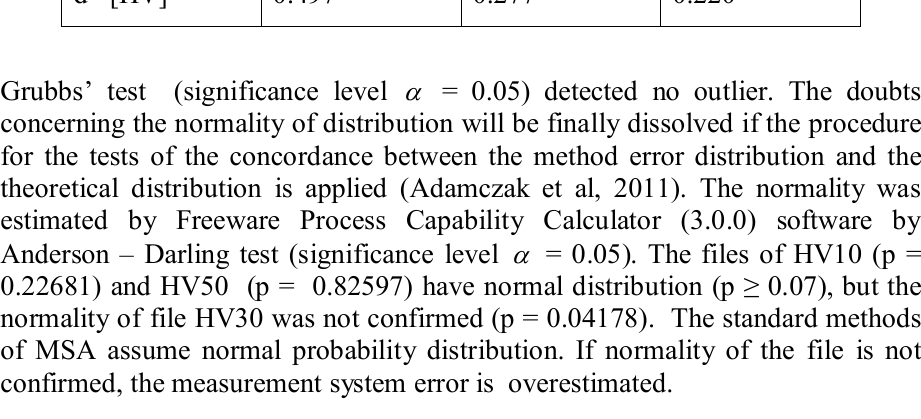
Table 2 – The average values of discrimination (effective resolution) d* HV10 HV30 HV50 d* [HV] 0.497 0.277